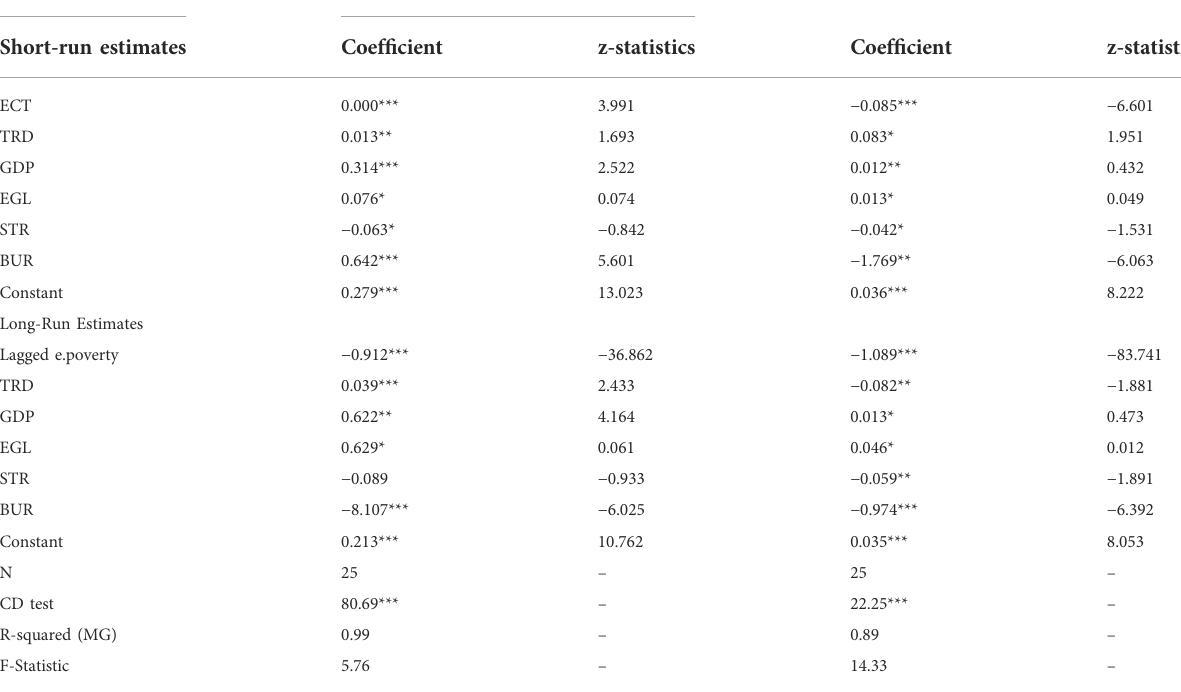
TABLE 5 Panel Empirics using CS-ARDL Estimations.